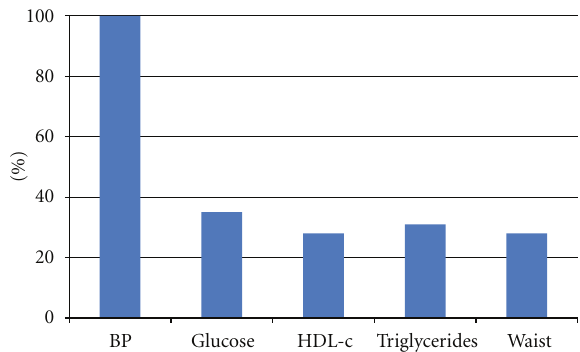
Figure 2: Proportion of criteria for metabolic syndrome in the study